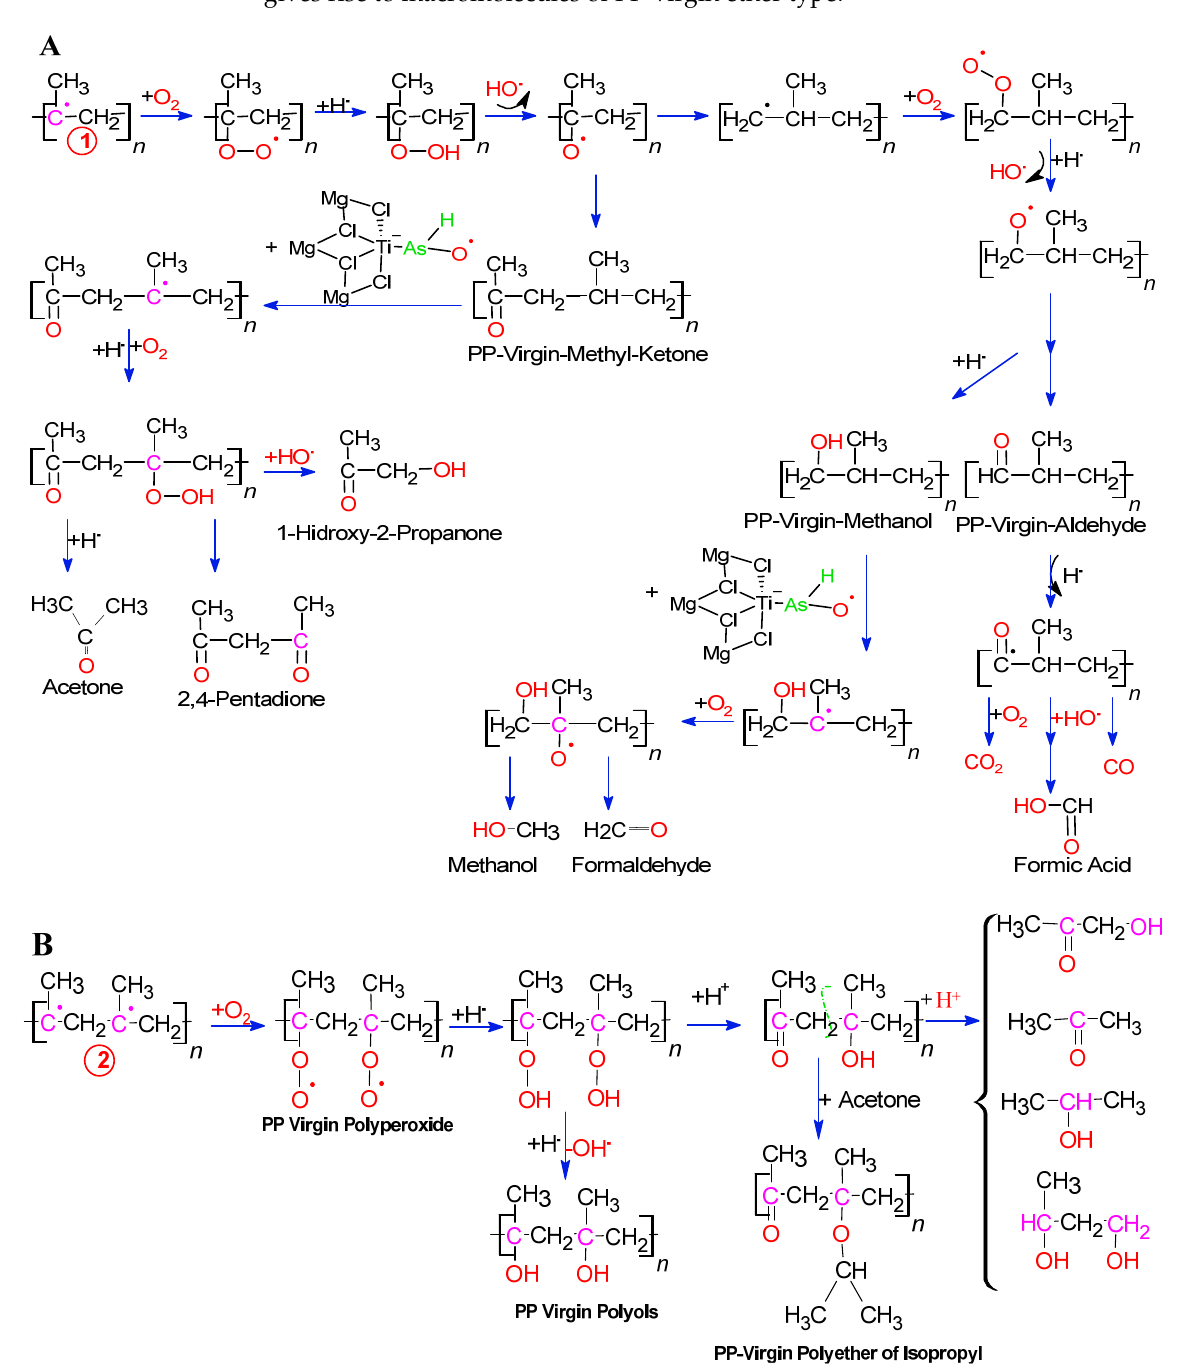
Figure 8. mechanisms of reaction of peroxy radicals in arsenic complexes to form VOCs. Figure 8. Mechanisms of reaction of peroxy radicals in arsenic complexes to form